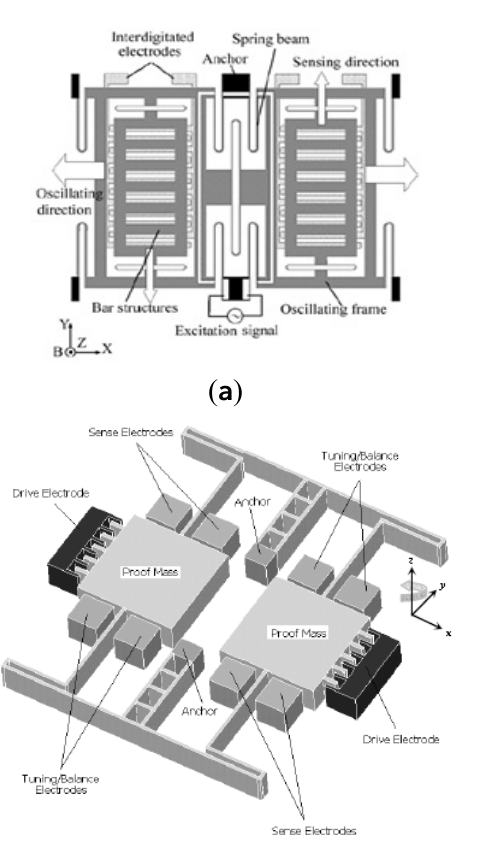
Figure 3. Various TFGs. ( a ) SIMIT. ( b ) PKU. ( c ) Georgia Tech. ( d ) CEA-LETI. ( e ) National University of Defense Technology (NUDT). ( f )